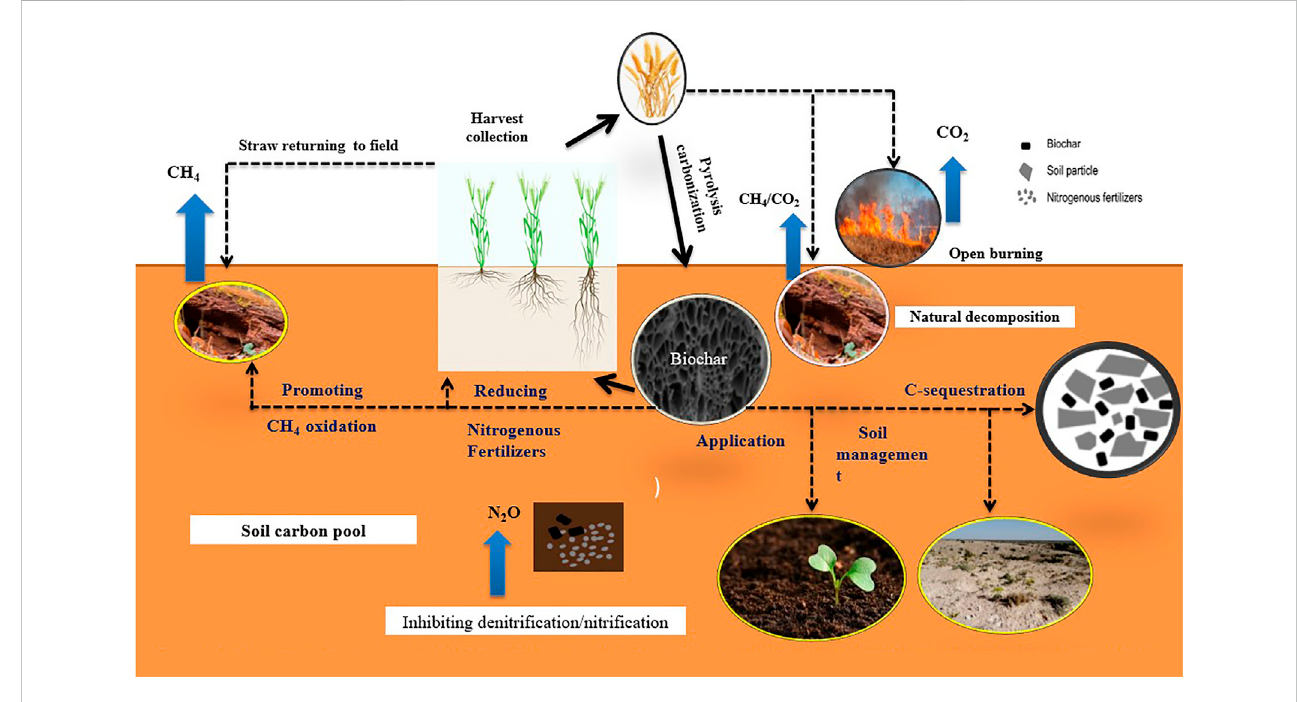
FIGURE 4 Mechanism of greenhouse gas (GHG) reduction and soil carbon (C) sequestration through biochar application; Carbon dioxide (CO 2 ), Methane (CH 4 ), Nitrous oxide (N 2O